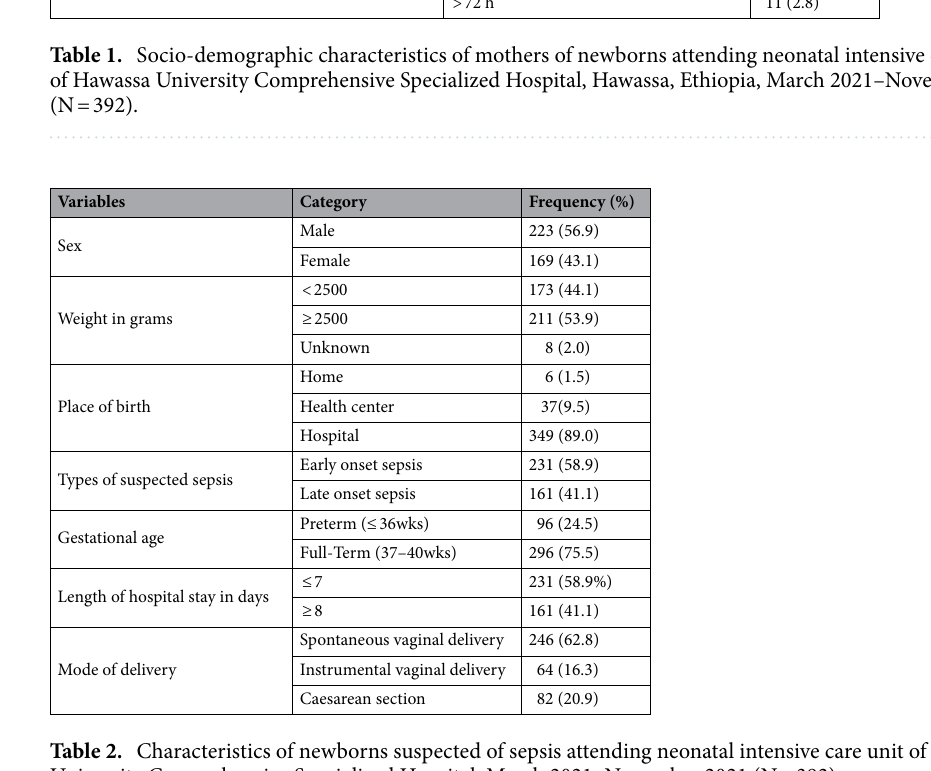
Table 2. Characteristics of newborns suspected of sepsis attending neonatal intensive care unit of Hawassa University Comprehensive Specialized Hospital, March 2021–November 2021 (N = 392).